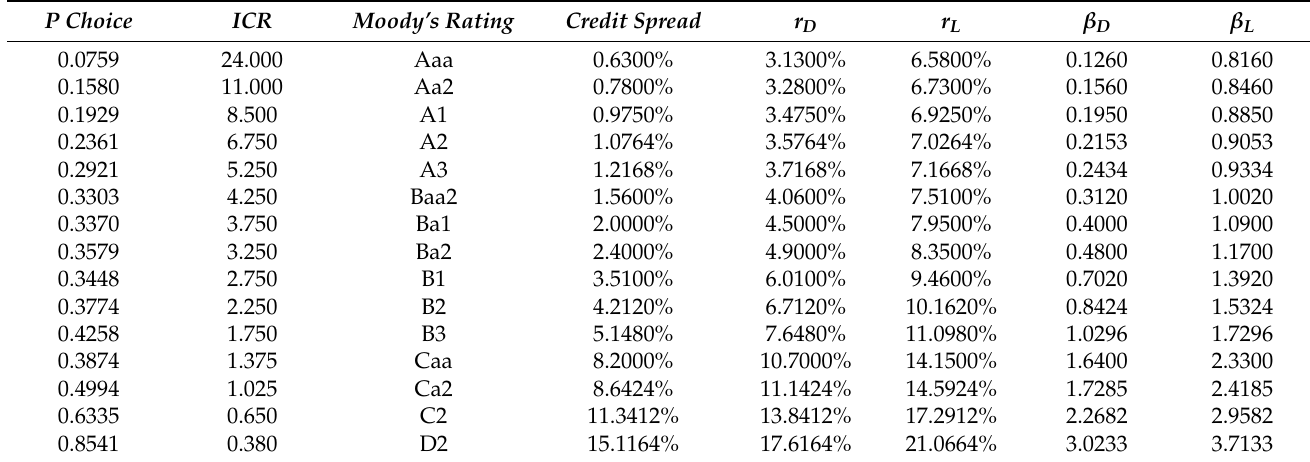
Table 1. Costs of